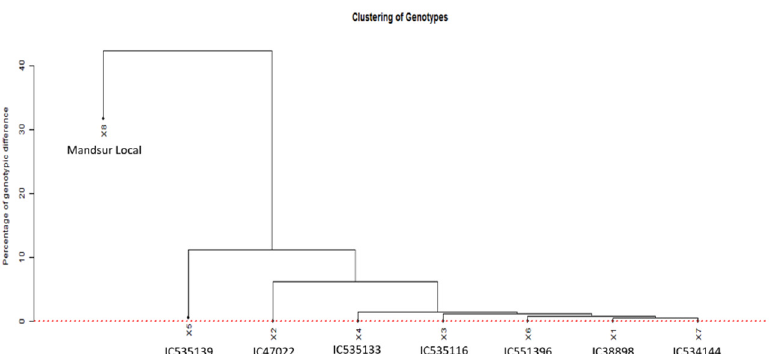
Figure 3. The relationship among the germplasms using the homozygous genotypic difference, computed based on identity-by-state analysis (1X = C138898, 2X = IC47022, 3X = IC535116, 4X = IC535133, 5X = IC535139, 6X = IC551396, 7X = IC534144, and 8X = Mandsaur Local).